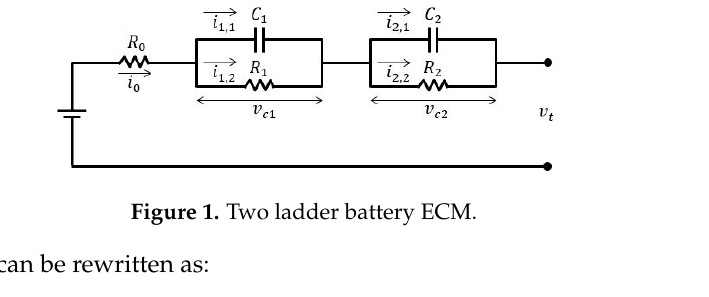
Figure 1. Two ladder battery ECM.